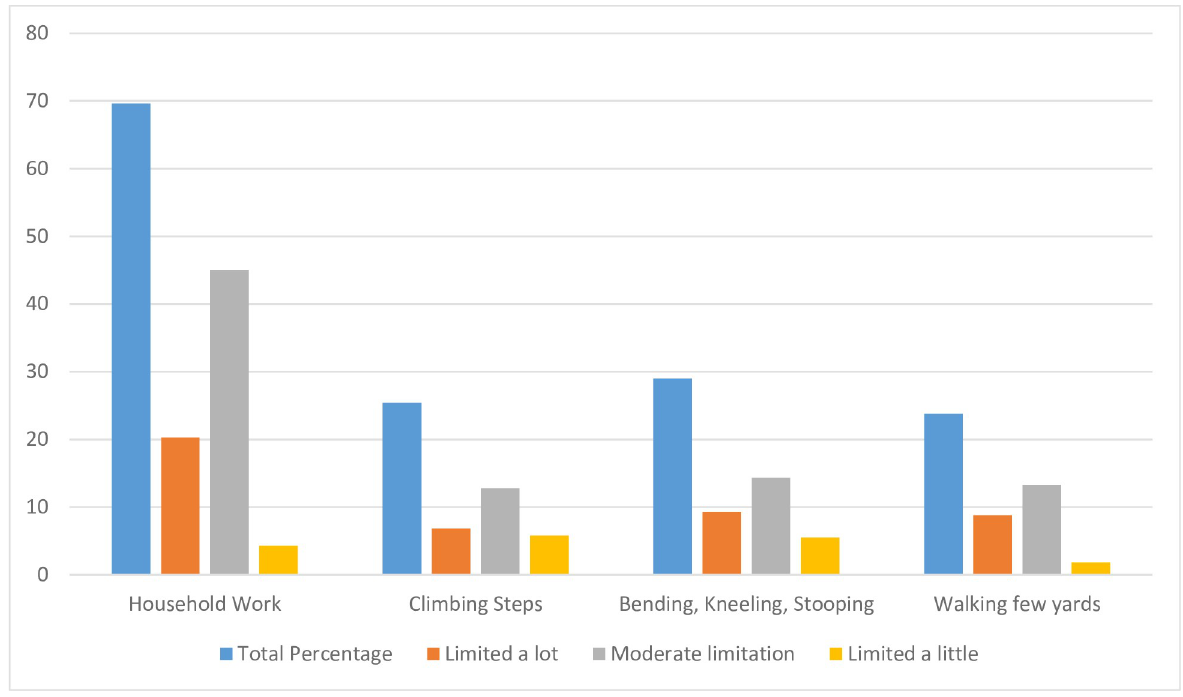
Fig 4. Limitation on daily activities among indigenous older adults with